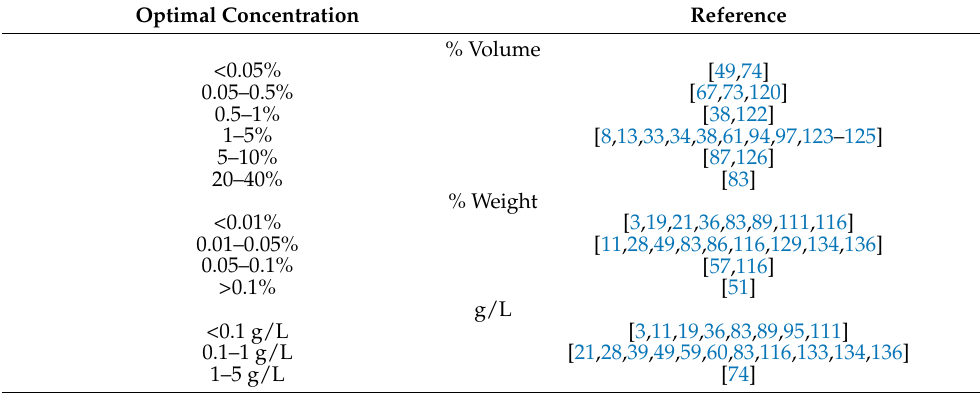
Table 18. Optimal concentrations of nanofluids with respect to their dielectric properties.